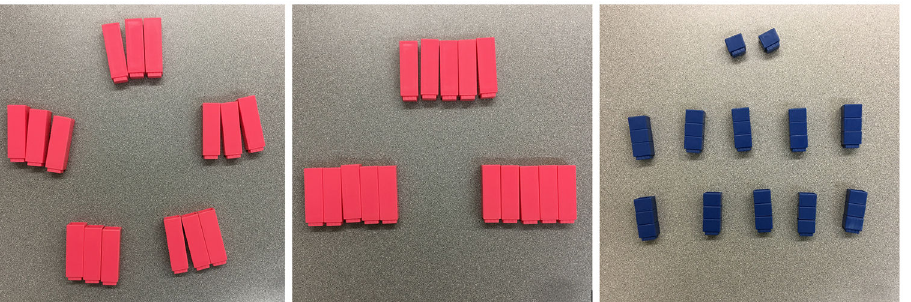
Figure 2. Sample end states for the modeling task for partitive division of 15 ÷ 5 (Panel A), quotative division of 15 ÷ 5 (Panel B), and quotative division of 8 ÷ 3/4 (Panel